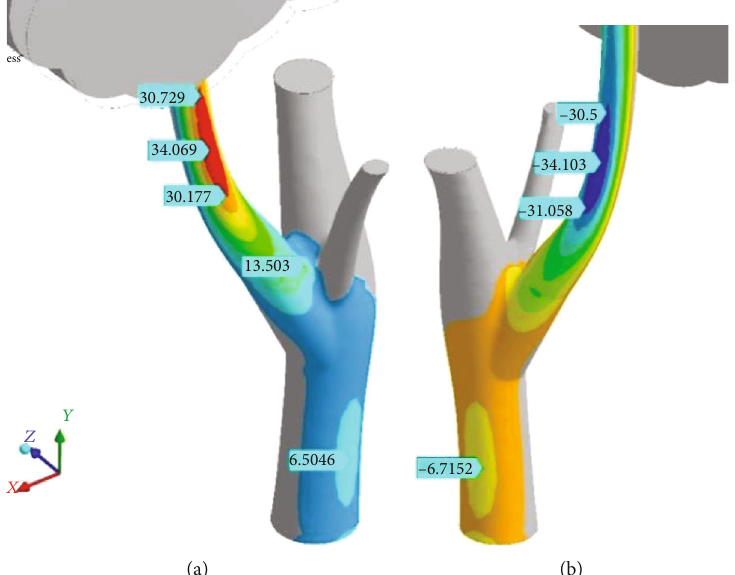
σ 3 ) (b) from leeward. Pressure